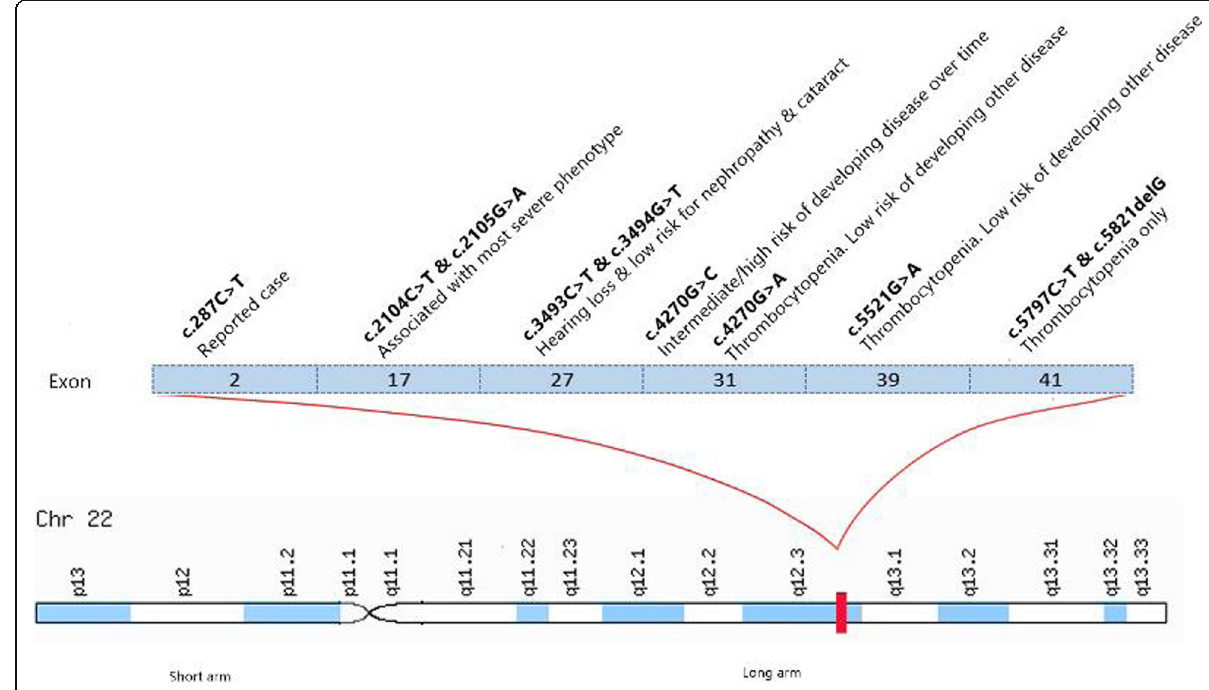
Fig. 1 MYH9 exons and mutations. Notable MYH9 pathogenic variants described by Savoia and Pecci (2021)